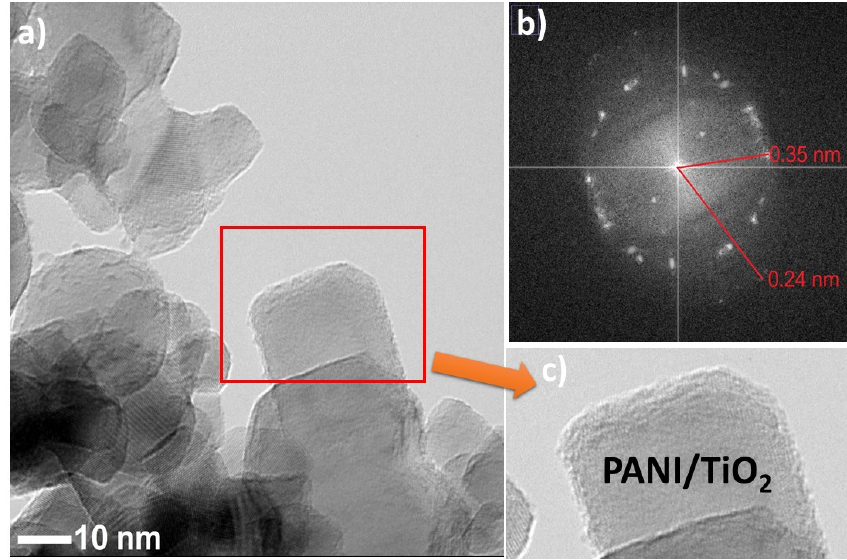
Figure 4. ( a ) TEM image of PANI–TiO 2 ; ( b ) FFT analysis of PANI–TiO 2 nanocomposite; ( c ) magnification Figure 4. a ) TEM image of PANI–TiO 2 ; b ) FFT analysis of PANI–TiO 2 nanocomposite; c ) magnification on PANI–TiO 2 on PANI–TiO 2 structure.